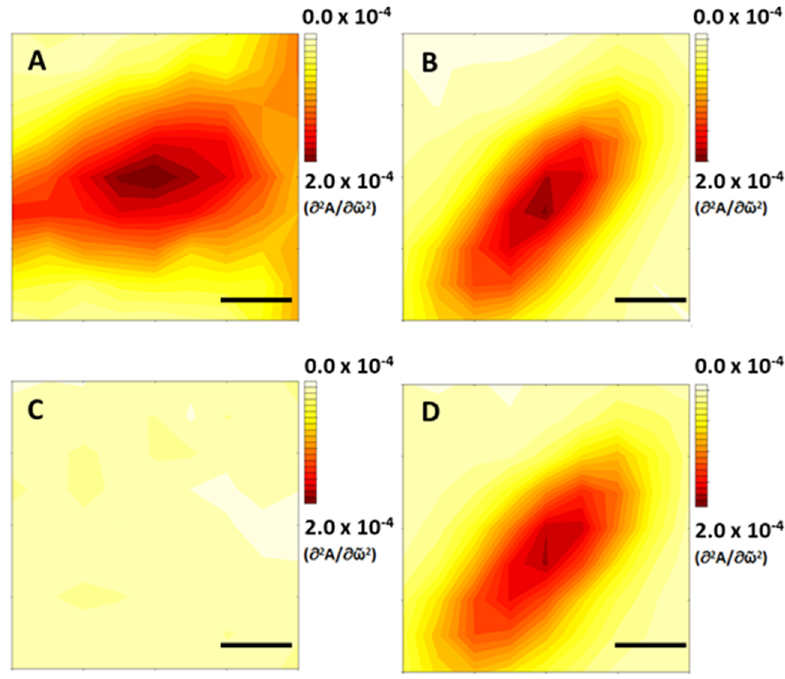
Figure 4. Transmission IR absorption maps of SH-SYS5 cells. ( A ) Map at 1652 cm − 1 of an untreated SH-SY5Y cell following fixation. ( B ) Map at 1652 cm − 1 of an SH-SY5Y cell following treatment with 100 µ g / mL MAPbI 3 and fixation. ( C ) Map at 1627 cm − 1 of the same SH-SY5Y cell as in A. ( D ) Map at 1627 cm − 1 of the same treated SH-SY5Y cell as in ( B ). All maps show the distribution of minus the intensity of the second derivative of absorbance at the given wavenumber value. The cells treated with MAPbI 3 show an intense absorption band at 1627 cm − 1 with approximately the same distribution as the 1652 cm − 1 component of the Amide I band. The 1627 cm − 1 band is absent in the untreated cell. Scale bar: 20 µ m. Figure reproduced and modified from [6] (I.B. doctoral thesis).